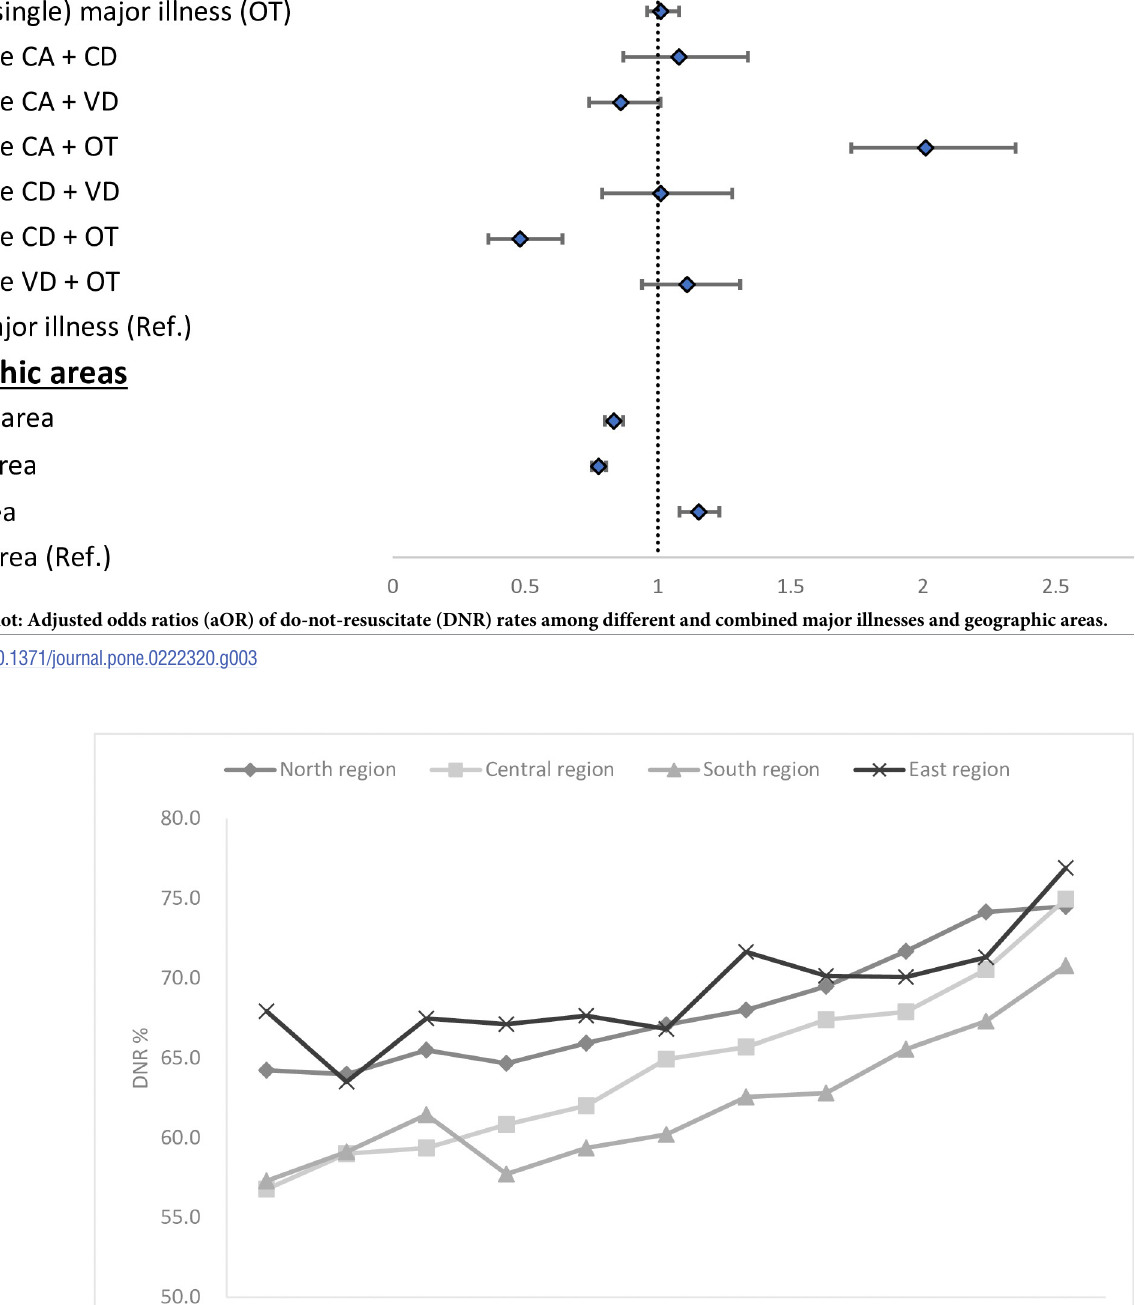
PLOS ONE | https://doi.org/10.1371/journal.pone.0222320 September 12,